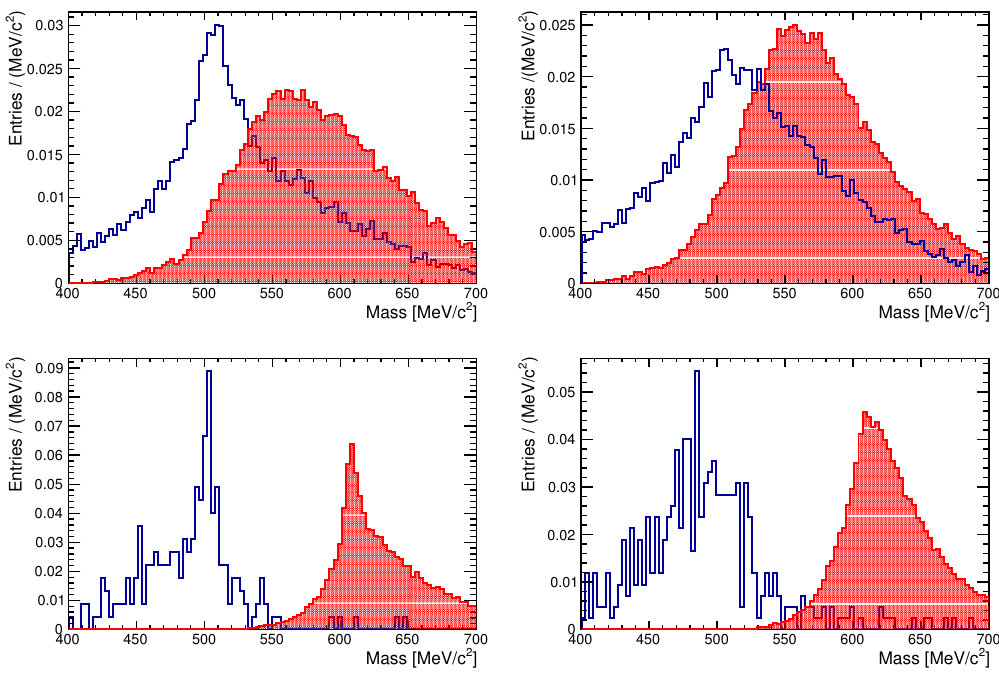
Figure 6 . Reconstructed invariant mass for K 0 (cid:13)(cid:22) + (cid:22) (cid:0) (top) and K 0 (cid:25) 0 (cid:22) + (cid:22) (cid:0) (bottom) S ! S ! obtained from simulation. The K 0 (cid:13)(cid:22) + (cid:22) (cid:0) and K 0 (cid:25) 0 (cid:22) + (cid:22) (cid:0) signal events are shown with a S ! S ! solid blue line and the K 0 (cid:25) + (cid:25) (cid:0) background is illustrated with red (cid:12)lled histograms. The left S ! side portrays events reconstructed with long tracks, while reconstruction with downstream tracks are depicted on the